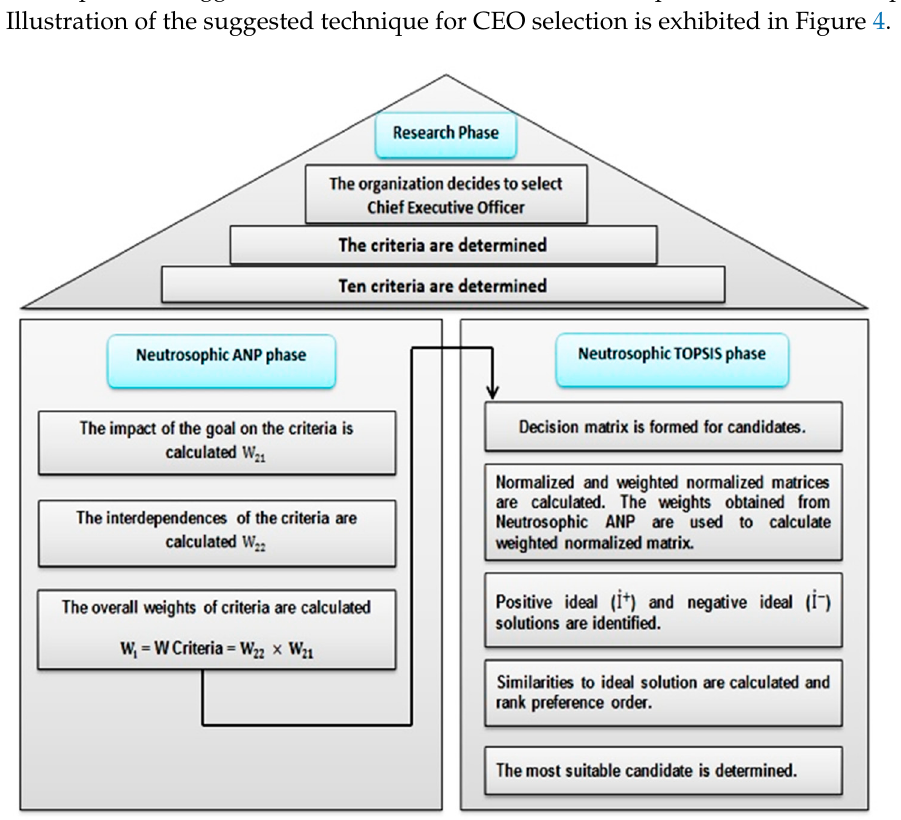
Figure 4. Suggested method.